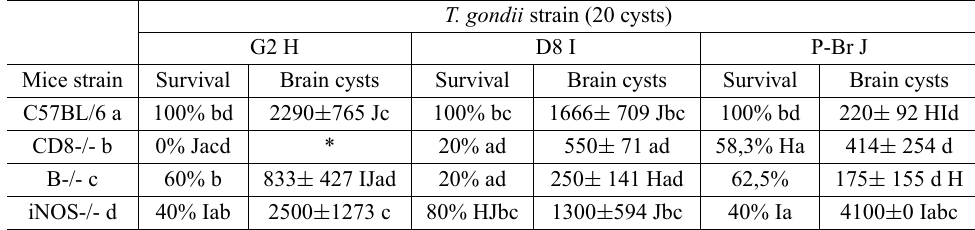
Brain cyst numbers and survival of mice infected with different Type I/III strains of T. gondii . T. gondii strain (20